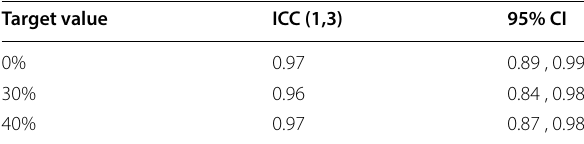
Table 3 ICC at each target value in normal walking conditions